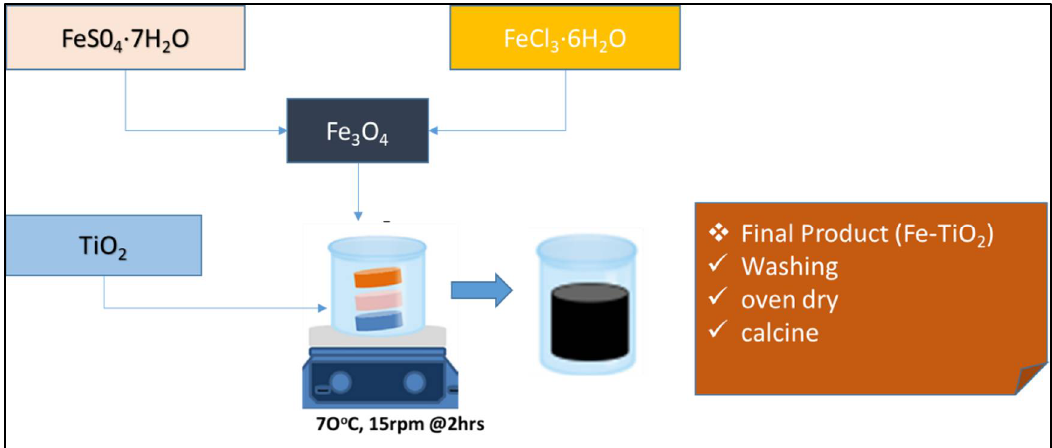
Figure 7. A schematic diagram of co-precipitation of magnetized photocatalyst (Fe-TiO 2 ).